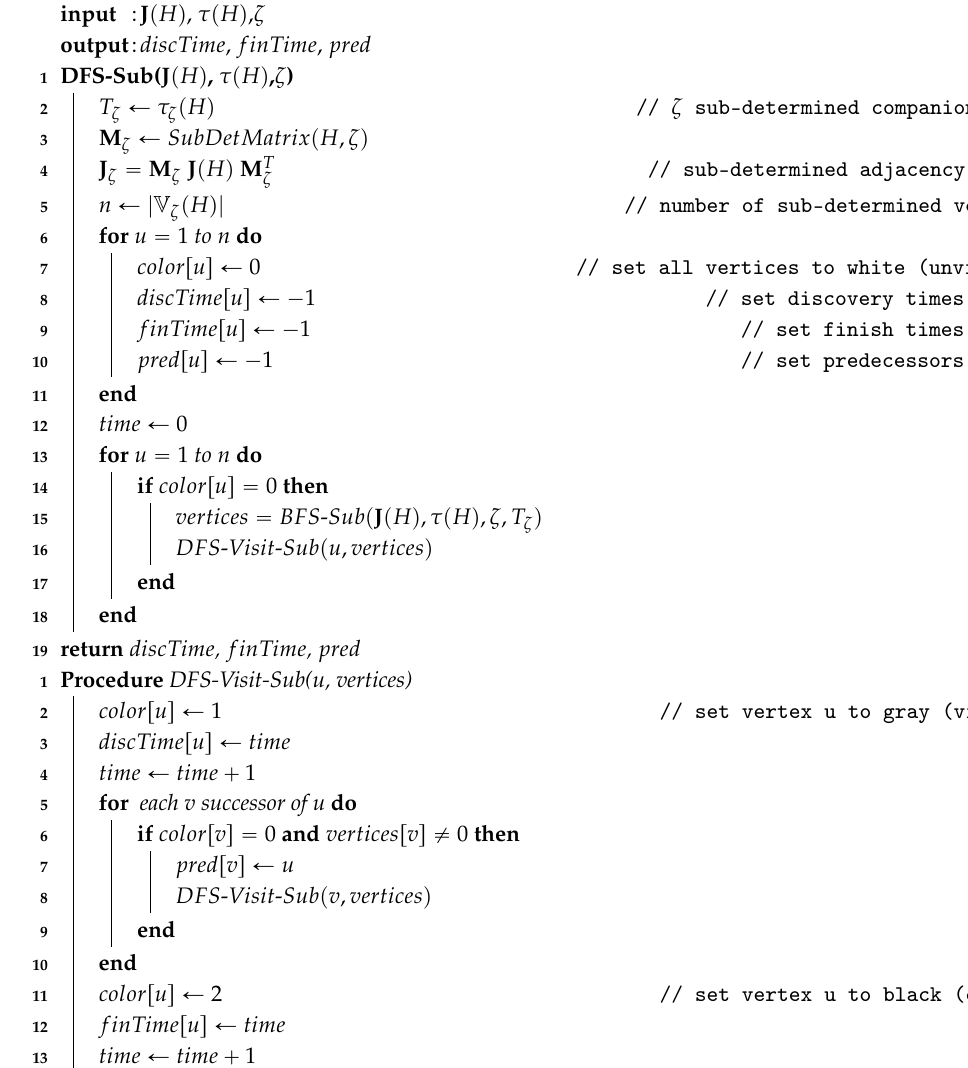
Algorithm 14: Sub-determined